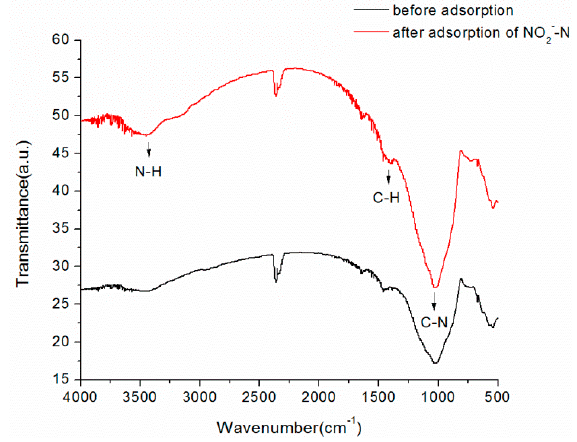
Figure 7. FT-IR spectrum of scoria before and after NO 2 − -N removal.